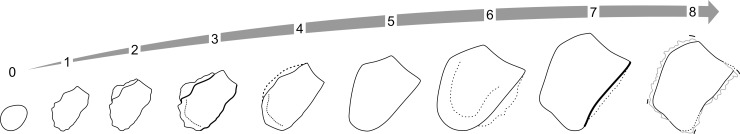
M5 and first phalange of digit 4 delta bone ossification stages.Stage -1 –Not present. Stage 0 –Very small oval shape undefined delta shape. Stage 1 –Axial surface starts to be linear consistent with delta shape. Stage 2 –one flat surface. Areas or slight irregular perimetral surface typically on the proximal side with a degree of adjacent mineralization which can oppose the epiphyseal surface but not necessarily show definitive osseous bridge formation. Bone density is clearly reduced in peripheral new bone in comparison to the primary ossification center. Stage 3 –Increased mineralization of adjacent proximal cartilaginous surface, consolidation may not be present. Stage 4 –Area increases in consolidation and mineralization, slightly less dense than the body of the delta bone. A defined hyper mineralized physeal plate line is present. The abaxial aspect can show the initiation of the new straight lateral border rather than horseshoe shape. Stage 5 –Density of secondary ossification center is similar to primary bone and initial mineralization present on distal surface with the proximal side showing defined straight lateral border rather than horseshoe shape. Individual variation may result in non-linear borders therefore emphasis should be placed on the secondary ossification centers on the proximal and distal surfaces. Stage 6 –Smooth proximal surface with matching density to the primary ossification center, distal surface still shows some incongruent mineralization. Physeal line is still visible denoted by dotted line. Stage 7 –Smooth proximal surface with complete consolidation of the secondary ossification center on both sides and dissolution of the physeal line. Stage 8 –Degenerative changes present.